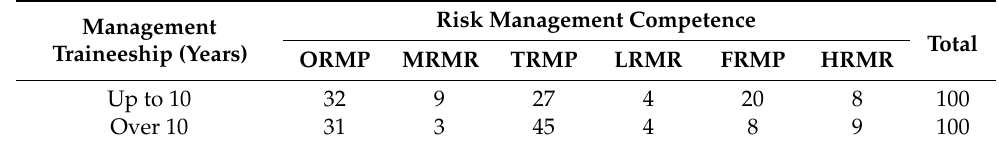
Abbreviations are as defined in Table